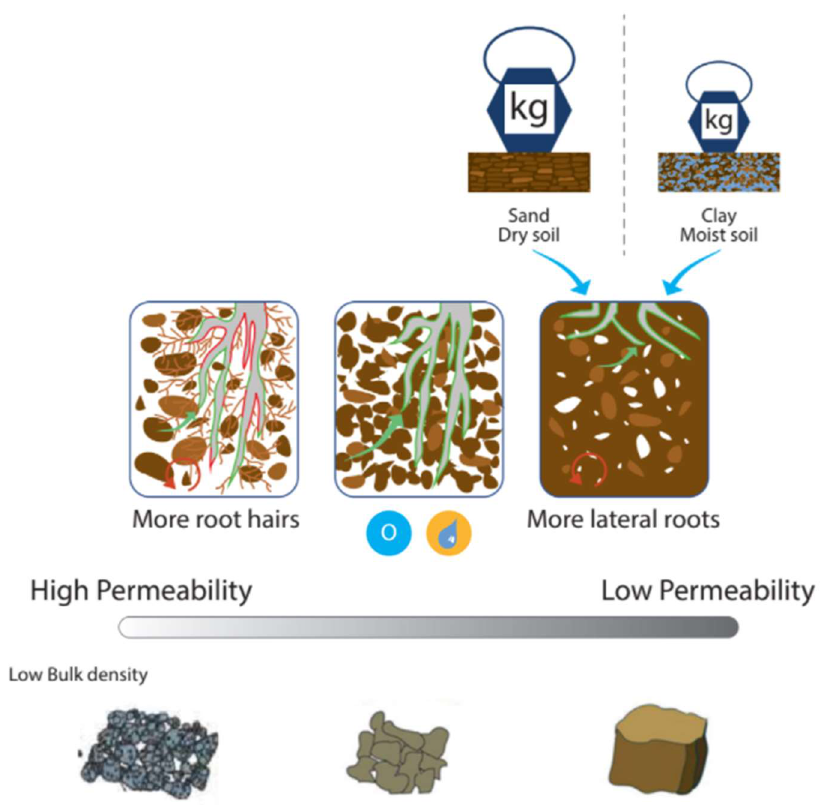
Figure 5. Soil–root interaction as a regulation of N uptake by the plant. Icons show: weight/pressure applied to dry and wet ground, and oxygen and water availability.